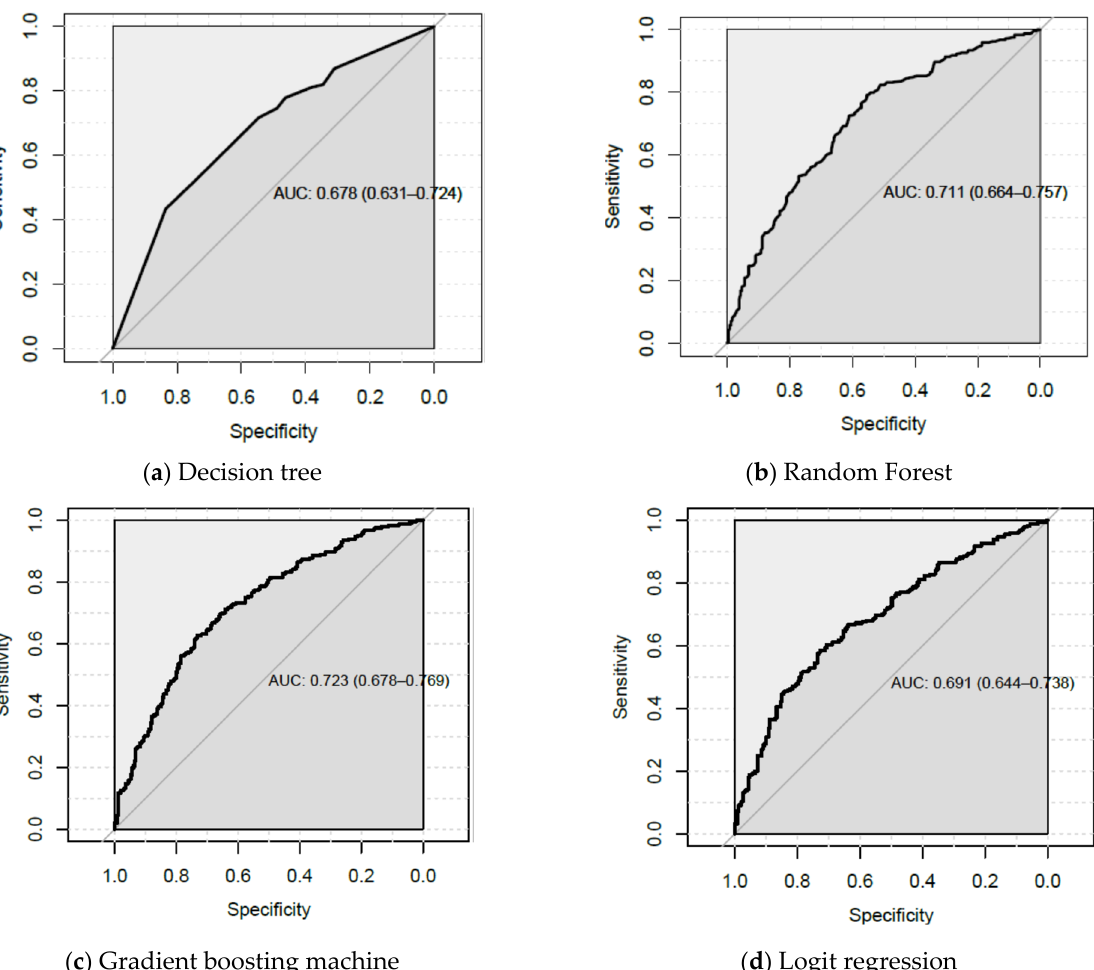
Figure 3. Receiver Operating Characteristics (ROC) curves for machine learning (ML) estimators (decision tree (DT), RF, GBM) and logistic regression model (LR).